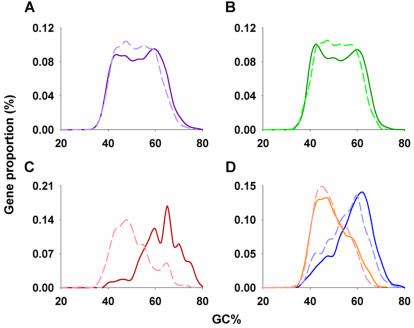
Distribution of GC content of promoter CpG island overlapping genes (PCI+, solid line) and non-promoter CpG island overlapping genes (PCI-, dash line).A, All genes; B, Genes with medium total intron size (10–50 kb); C, intronless genes; and D, genes with short total intron size (<10 kb, blue) and long intron size (>50 kb, orange).